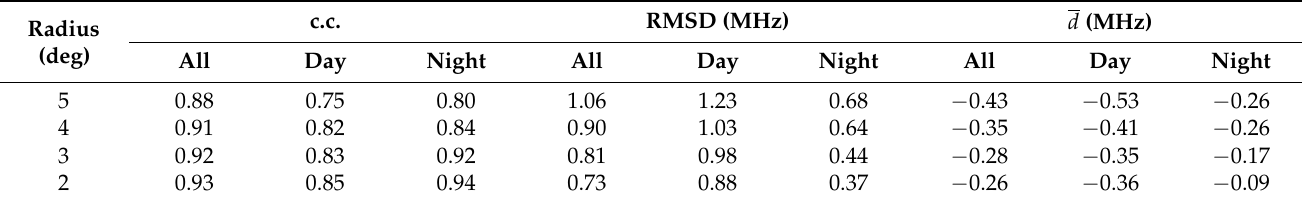
Table 3. Comparison of c.c., RMSD and mean difference ( d ) for hmF2.